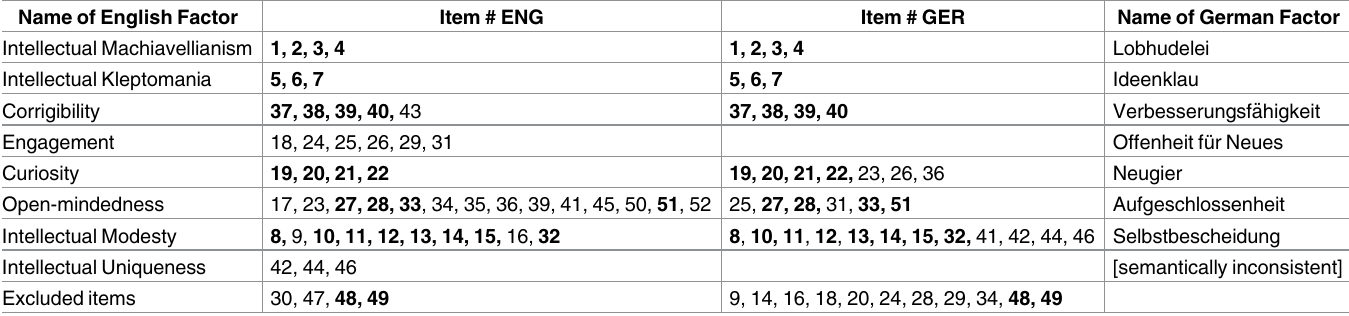
Table 11. Comparing the German with the English exploratory factor analysis. Name of English